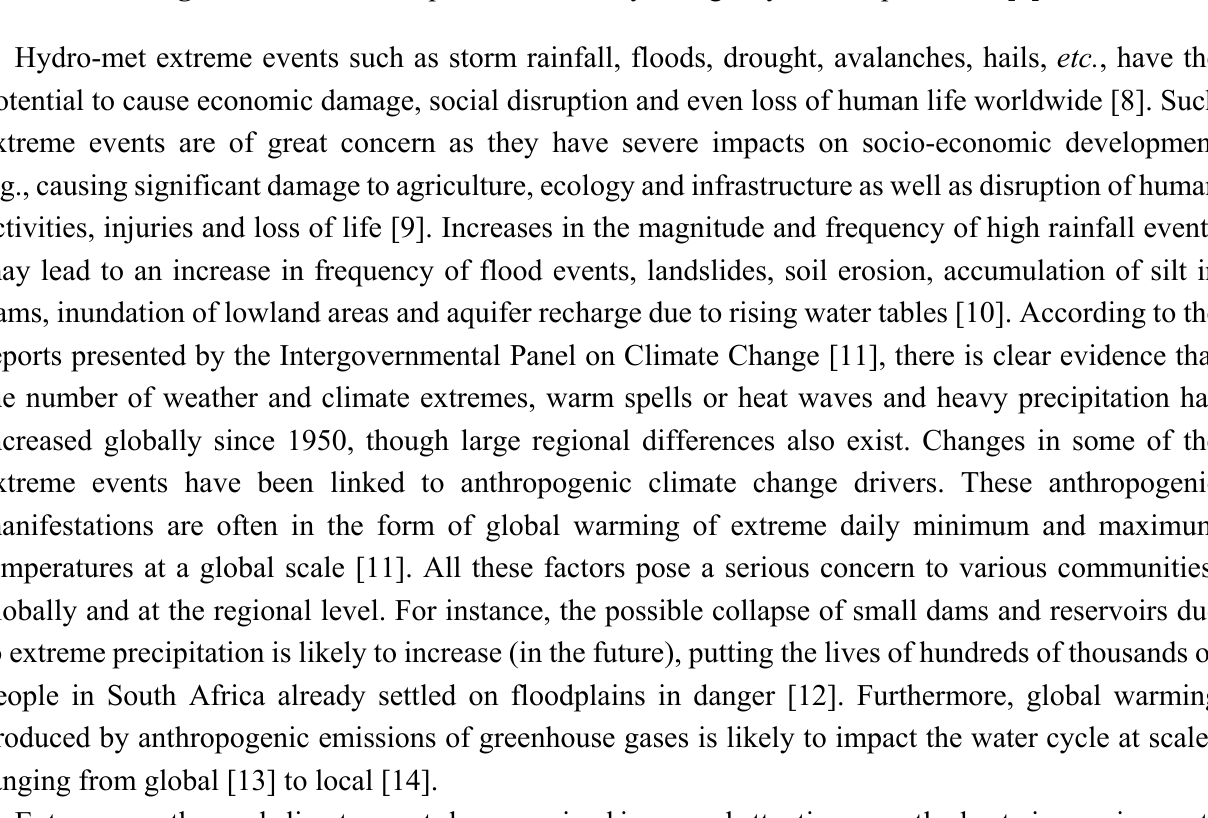
Figure 2. Schematic representation of hydrologic cycle. Adapted from